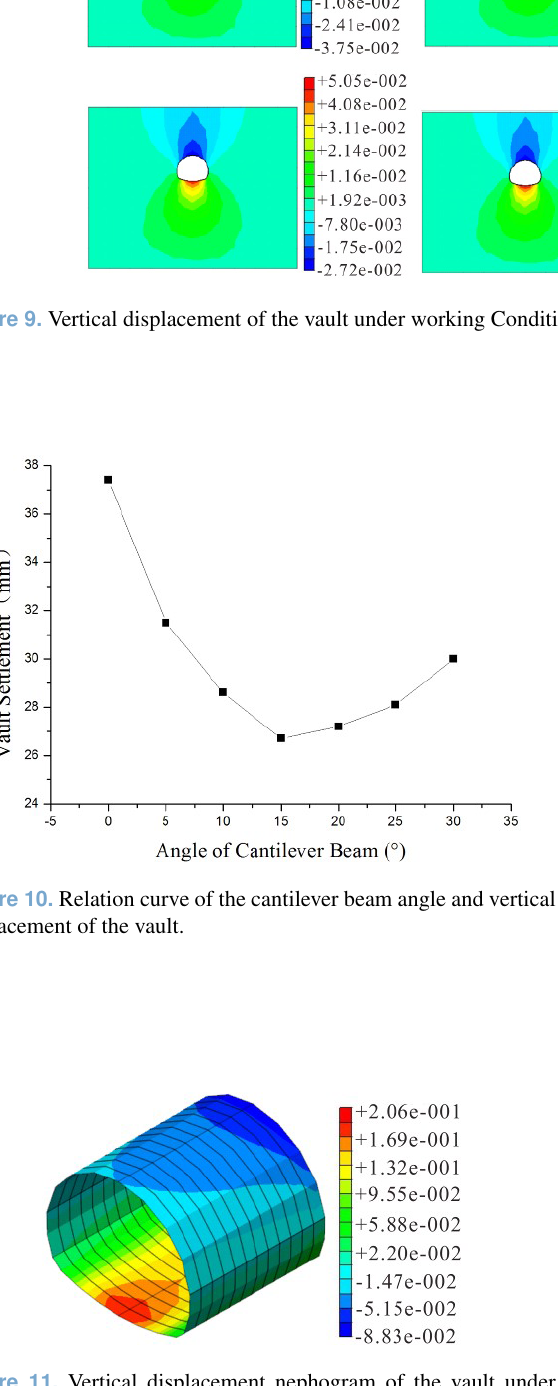
Figure 11. Vertical displacement nephogram of the vault under Condition 1 (mm).